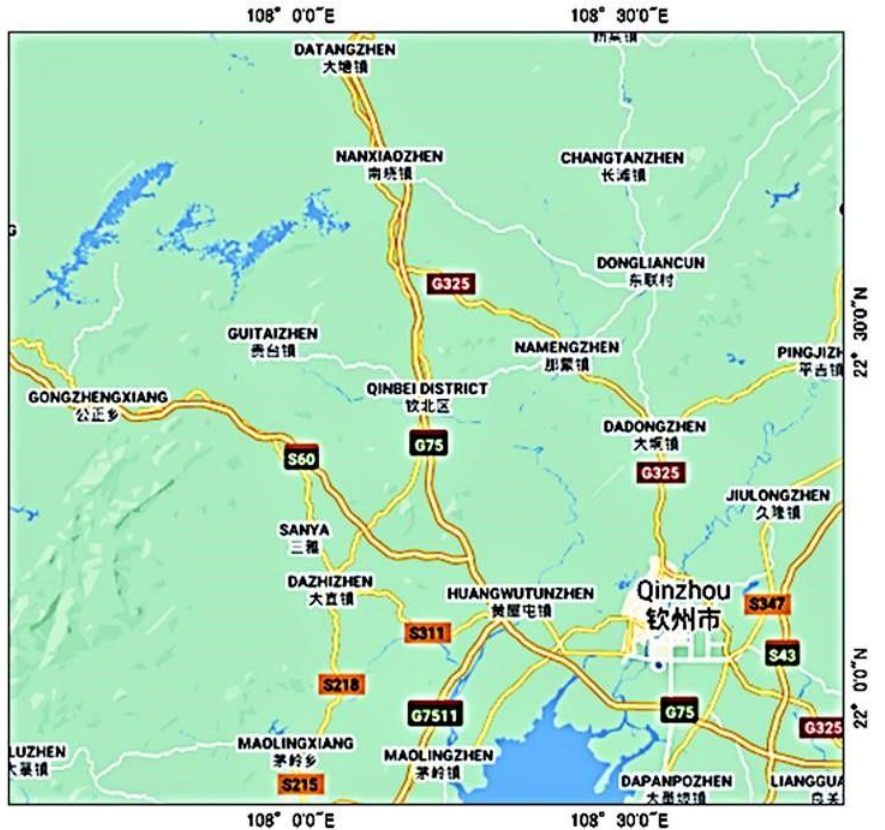
Figure 3. Map of Qinzhou Prefecture showing major district and county urban areas. The study site was Qinbei District north of the prefectural-level city of Qinzhou and in the area between highways G75 and G325.